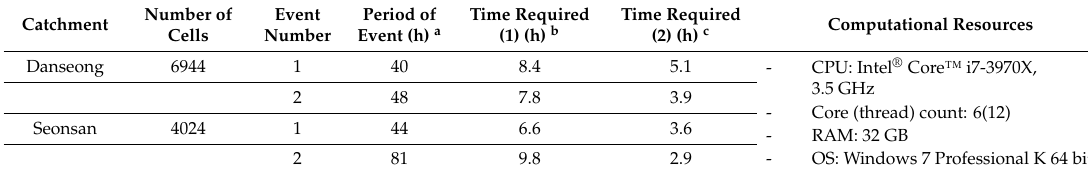
Table 6. Time required for parameter optimization for the GRM per